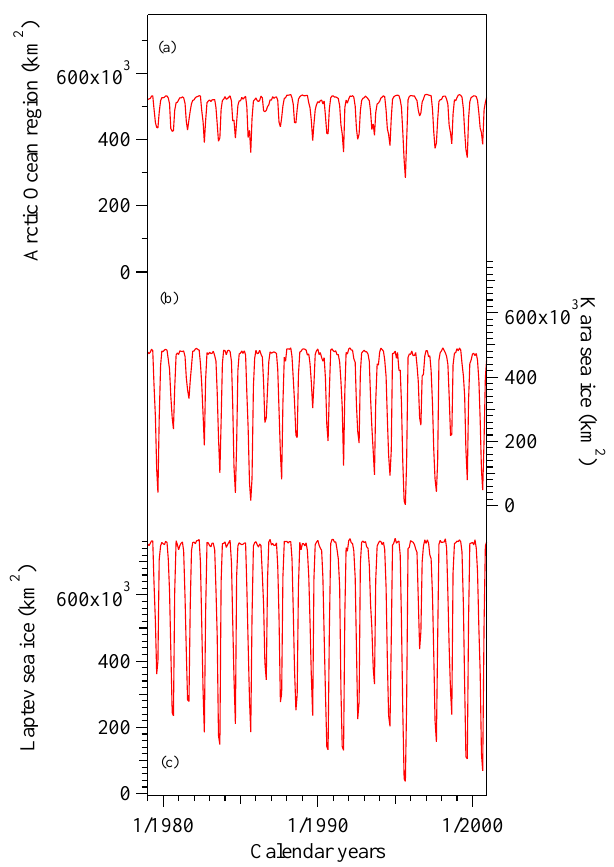
Figure 3. Sea ice area variation in the period 1979–2000 for the three regions defined in Fig. 1: (a) Arctic Ocean, (b) Kara Sea and (c) Laptev Sea. Laptev Sea sea ice shows the greatest seasonal vari-